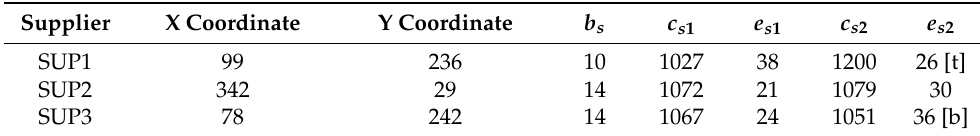
Table 6. Supplier information of P01.